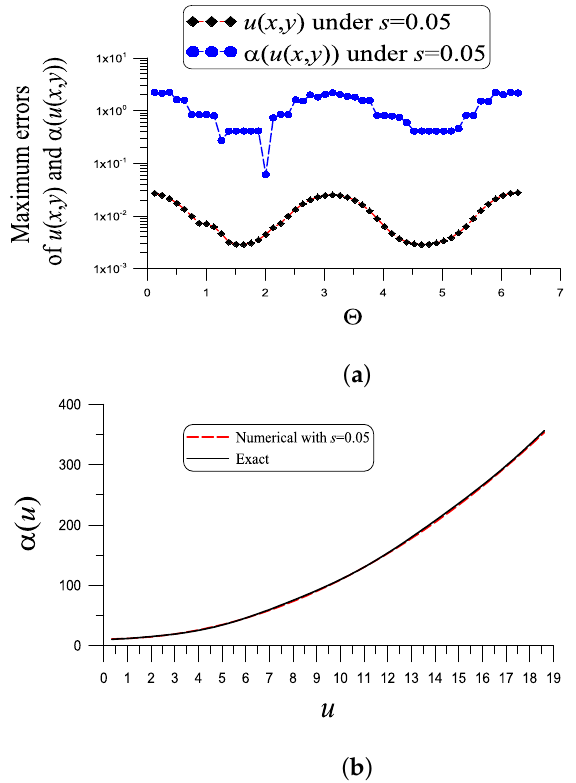
Figure 5. For example 4, showing ( a ) the errors in the numerical recovery of u and α and ( b ) the numerical recovery of α under a noise s =